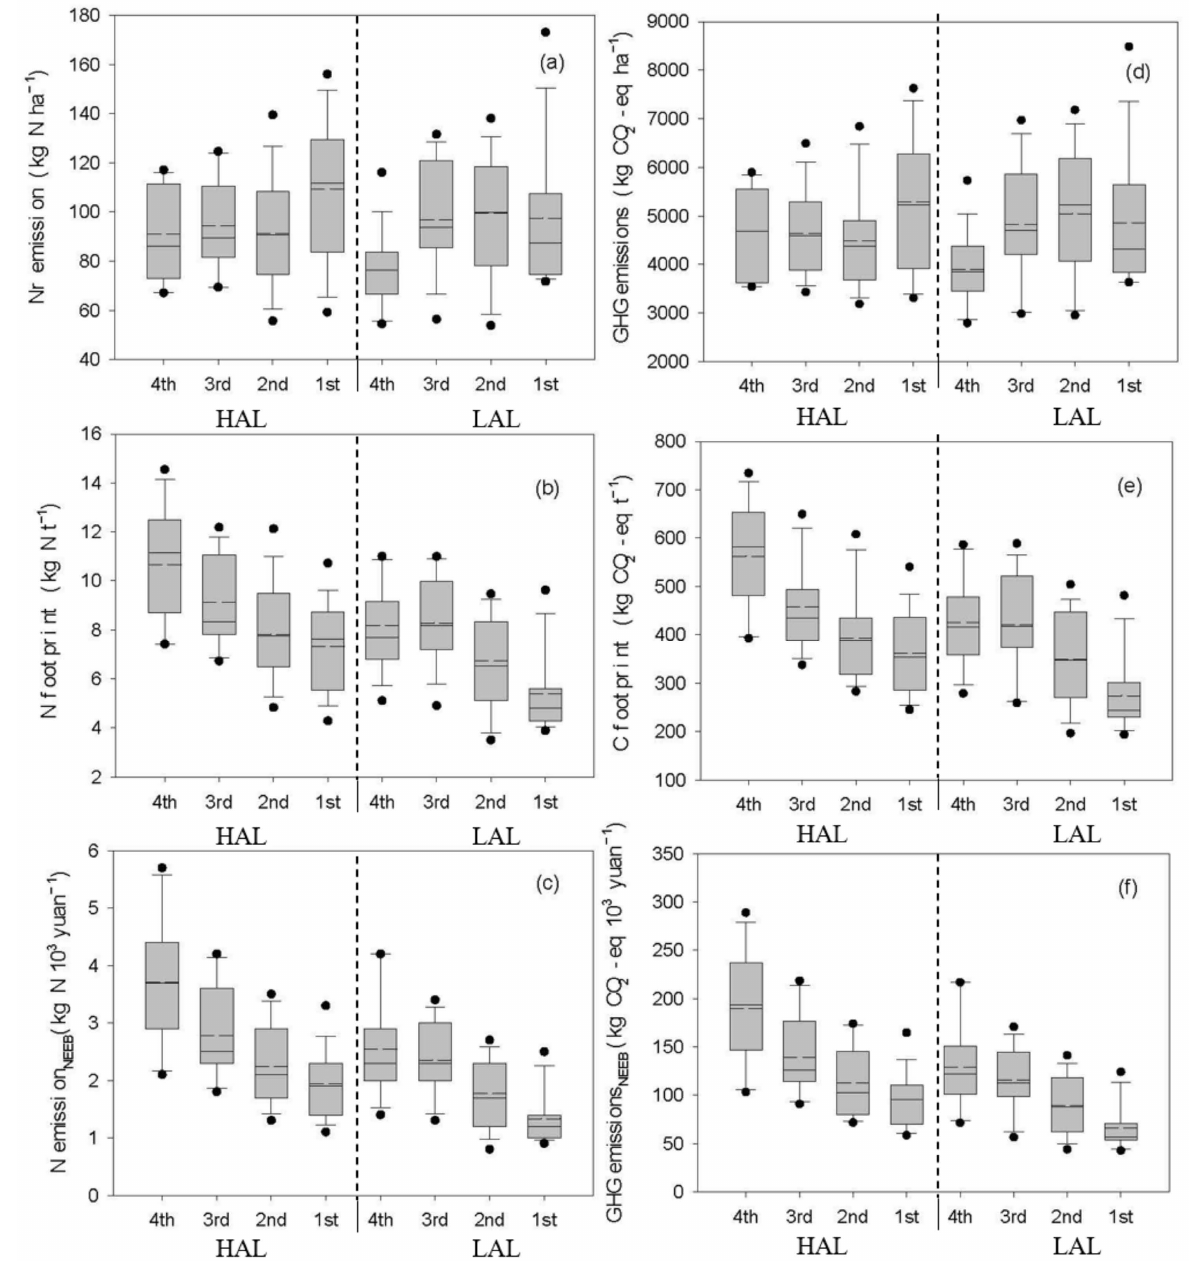
Figure 3. The Nr Emissions ( a ), N footprint ( b ), N emission NEEB ( c ), GHG emission ( d ), C footprint ( e ) and GHGemission NEEB ( f ) in different groups of open-field pepper production. The yield data from surveyed farmers were ordered from low to high and divided into four quartiles: 1st quartile (best 25%), 2nd quartile (50–75%), 3rd quartile (25–50%), and 4th quartile (lowest 25%). HAL represents the high-altitude level (500–600 m), and LAL represents the low-altitude level (900–1200